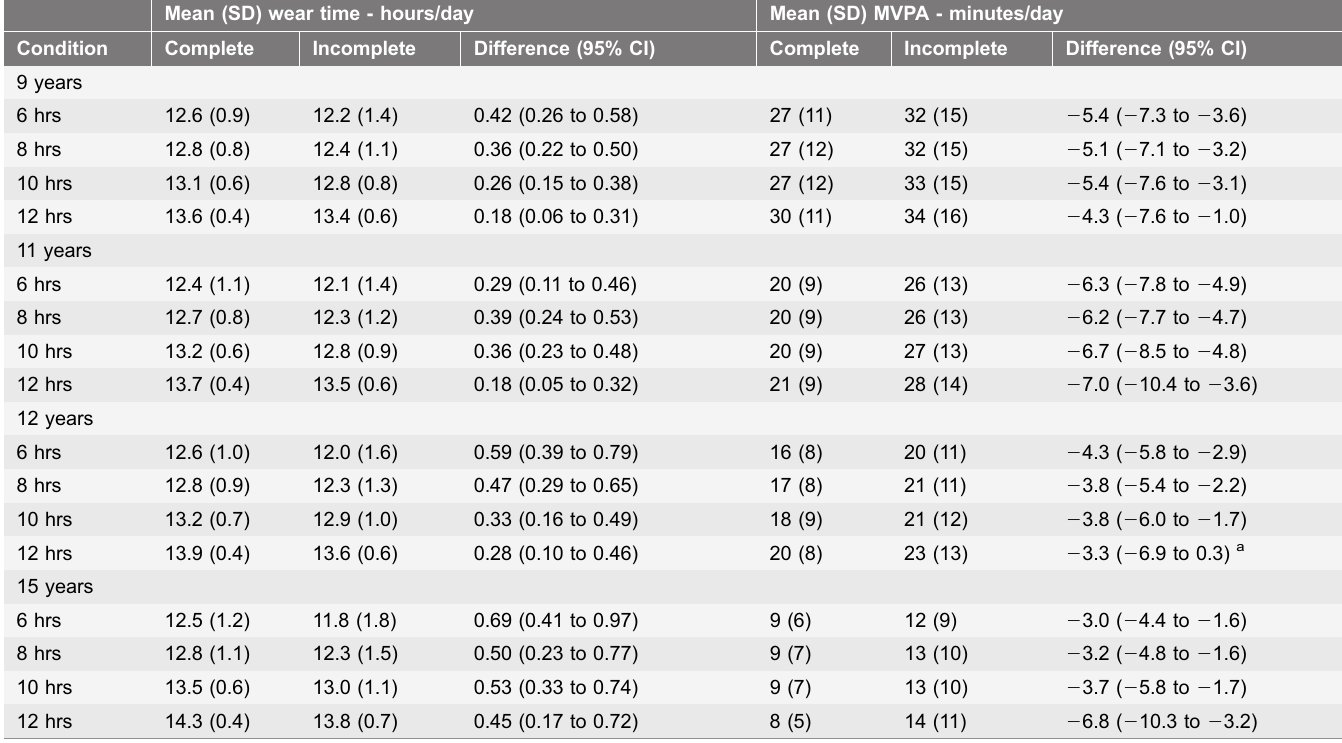
MVPA, moderate-to-vigorous physical activity; n d , number of days. a Mean difference in MVPA between complete and incomplete data was not significant (p . 0.05). Remaining mean difference values (wear time and MVPA) were